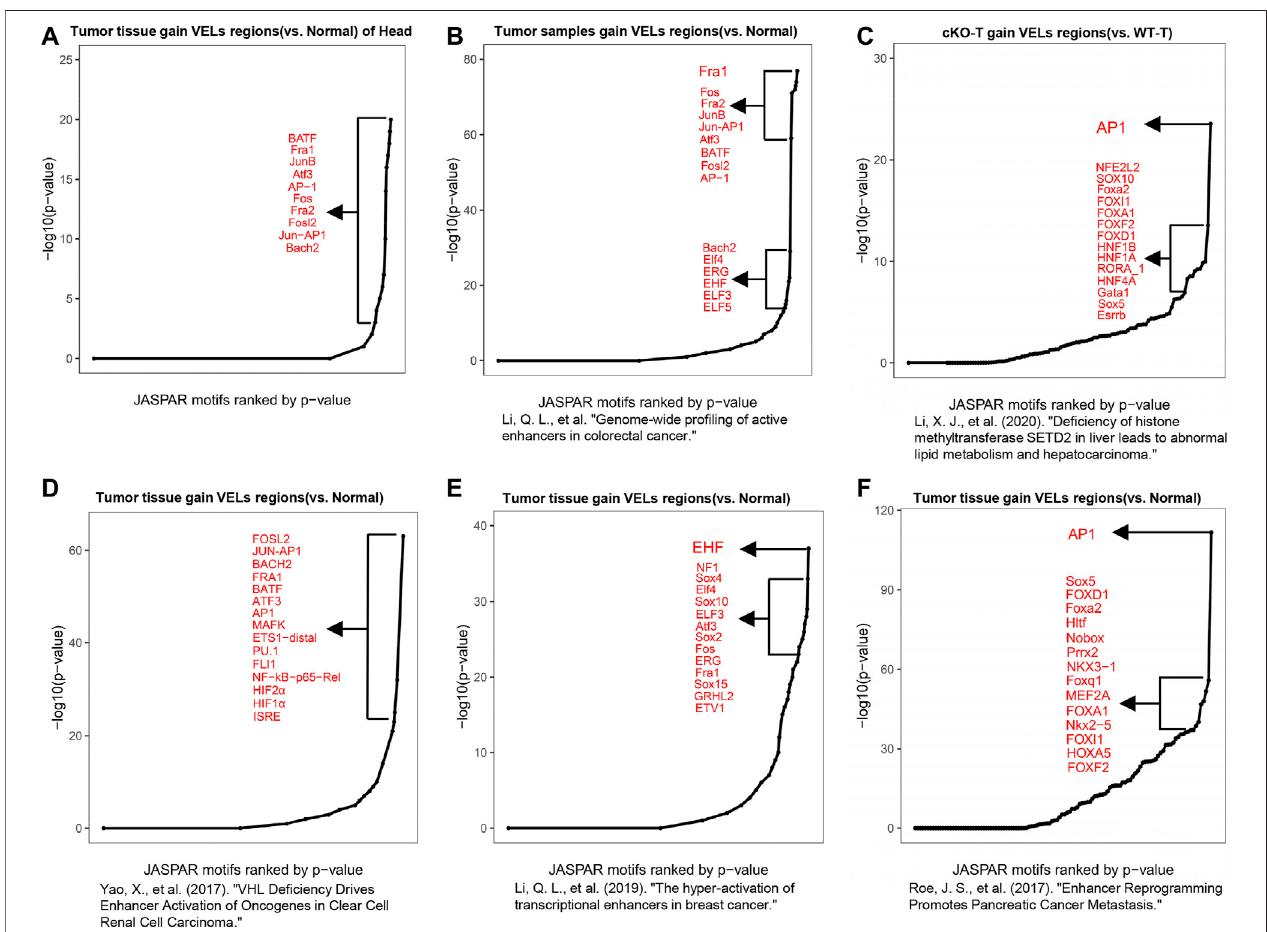
FIGURE 4 | Motif analysis predicted the roles of AP-1 in cancer. (A) Motif analysis with DNA sequence information of gain VELs in tumor predicted functional TFs andacurvewasdrawnaccordingto p valuesofTFs.Thetop10 TFswerelisted. (B – F) MotifanalysestopredictfunctionalTFswithpublishedH3K27acChIP-Seqdatain multiple cancers, including colorectal cancer (B) , hepatocarcinoma (C) , clear cell renal cell carcinoma (D) , breast cancer (E) , and pancreatic cancer (F) .